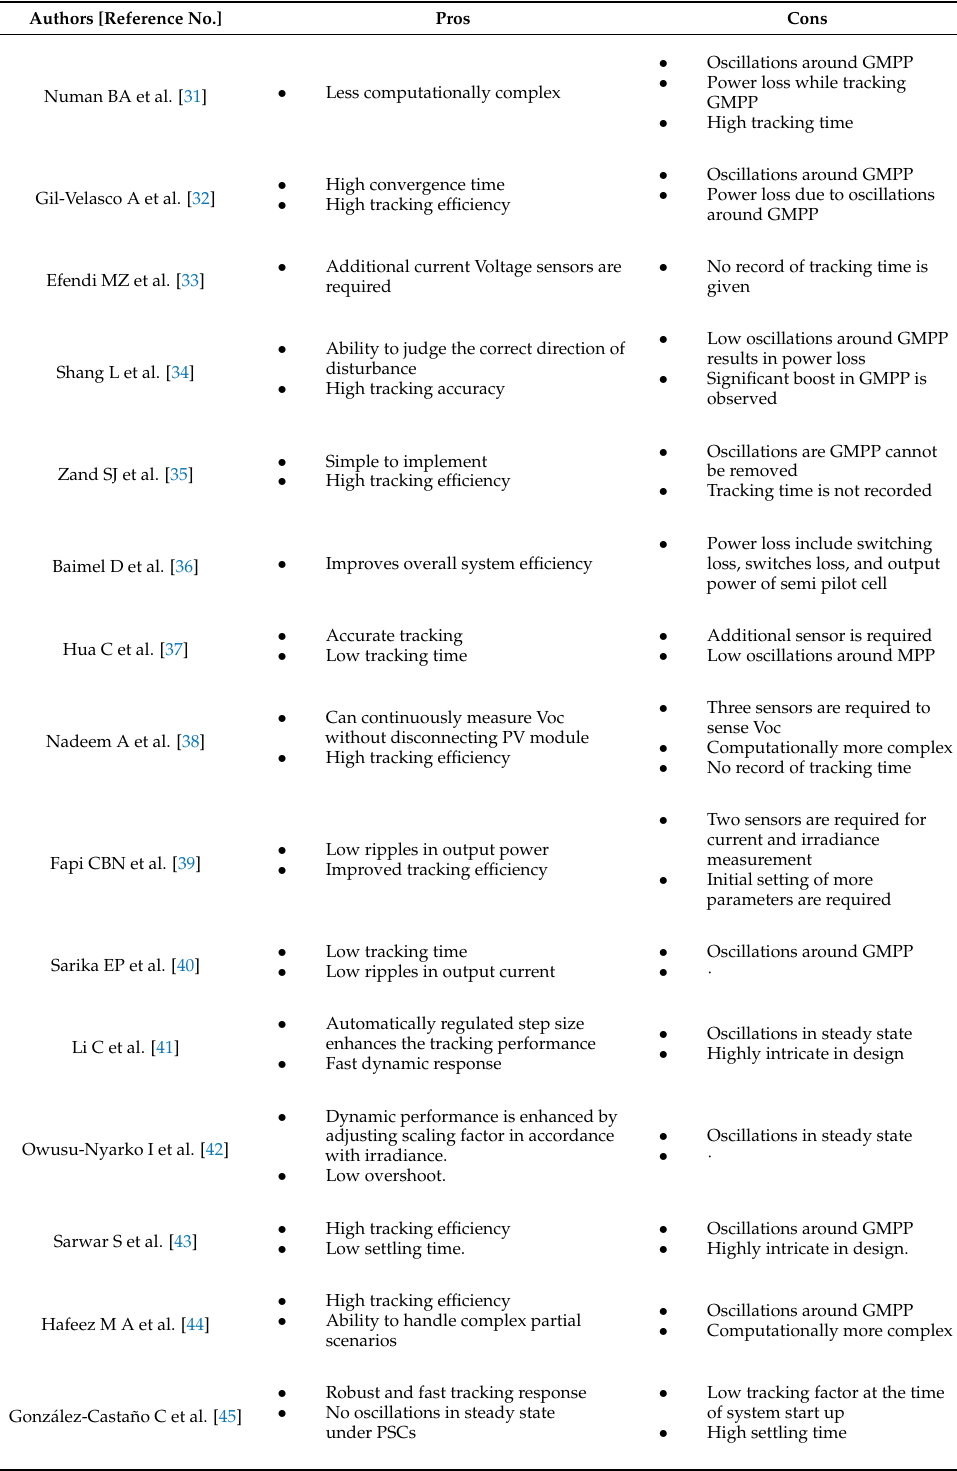
Table 2. Pros and cons of recent work based on conventional